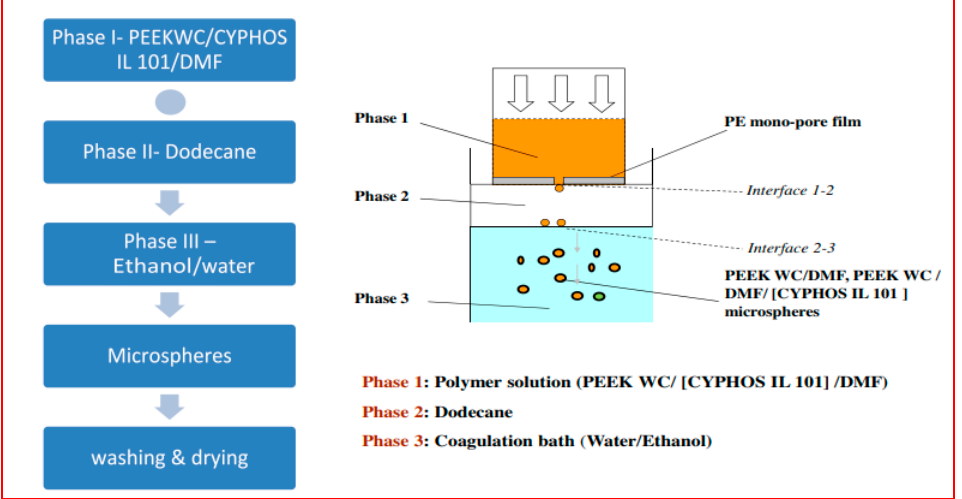
Figure 8. Process flow chart for the encapsulation of CYPHOS IL 101 into PEEKWC microspheres [55].